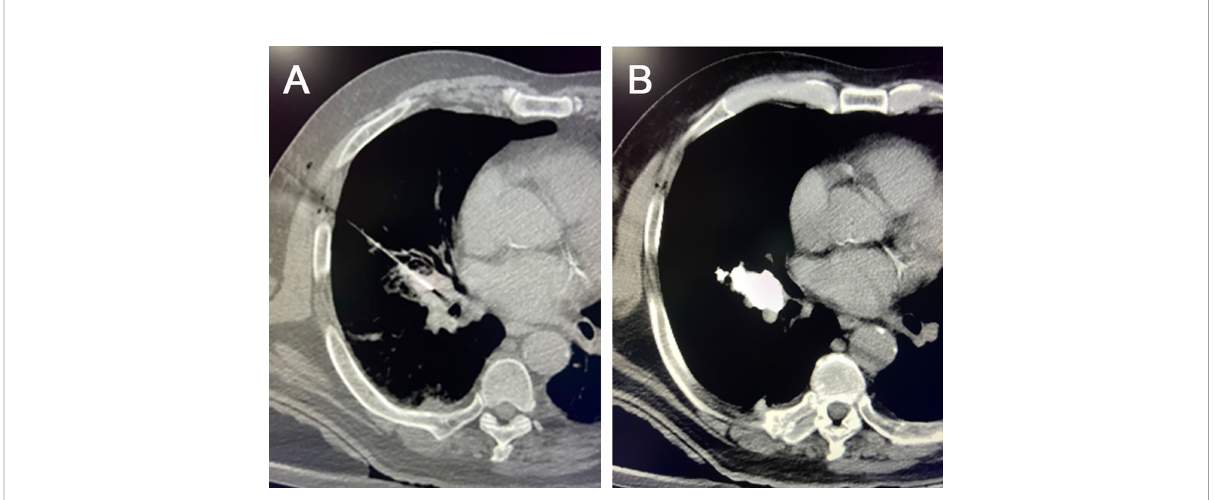
FIGURE 4 Chemo-immunoablation of right-sided central lung cancer. (A) A 22G puncture needle was used to reach the main part of the tumor, (B) followed by chemical ablation with cisplatin plus epoetin and intratumoral immunotherapy with 5-10 mg of pembrolizumab via needle sheath. A small amount of iodine oil was used as a tracer to observe the diffusion of the